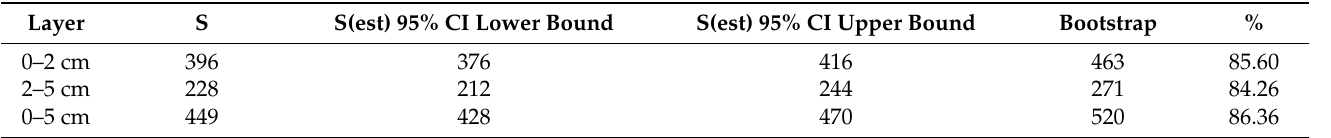
Table 2. The obtained and estimated richness (bootstrap) for the three studied layers of the Potiguar Basin Slope. S = richness observed; S(est) = Estimated